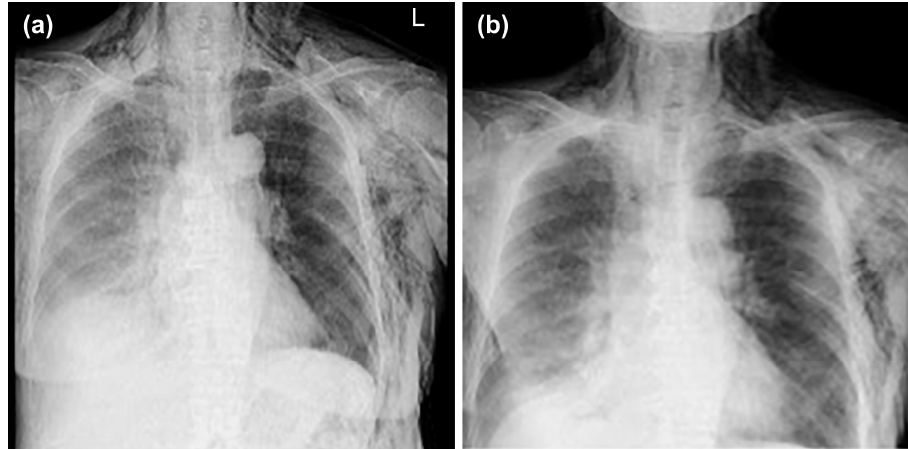
Figure 5. The clinical course after placement of the first thoracic cavity drain. Day 1 ( a ), Day 4 ( b ). No air leaks were observed; however, respiratory fluctuations were observed.